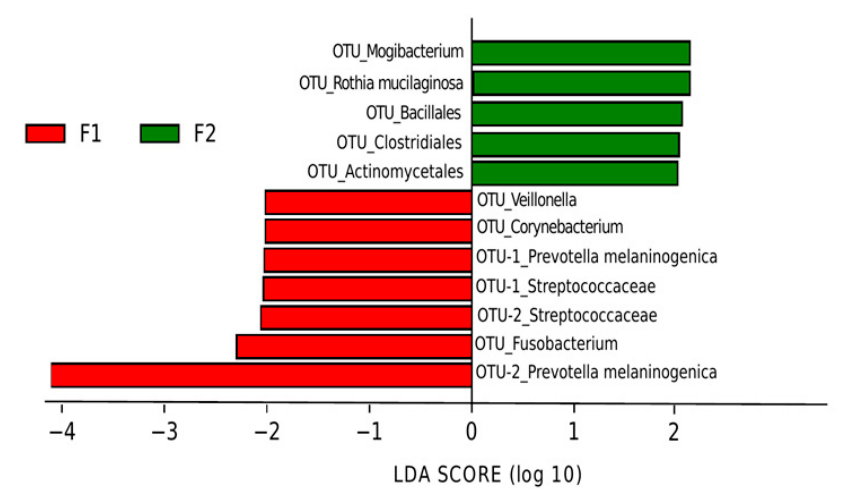
Figure 6. Linear discriminative analysis (LDA) effect size (LEfSe) at the OTU level in viremic untreated group (VU) before (F1) and after (F2) prebiotic intervention. LDA scores for the significant taxa in F2 are represented on the positive scale (green), and LDA-negative scores represent enriched taxa in F1 (red).